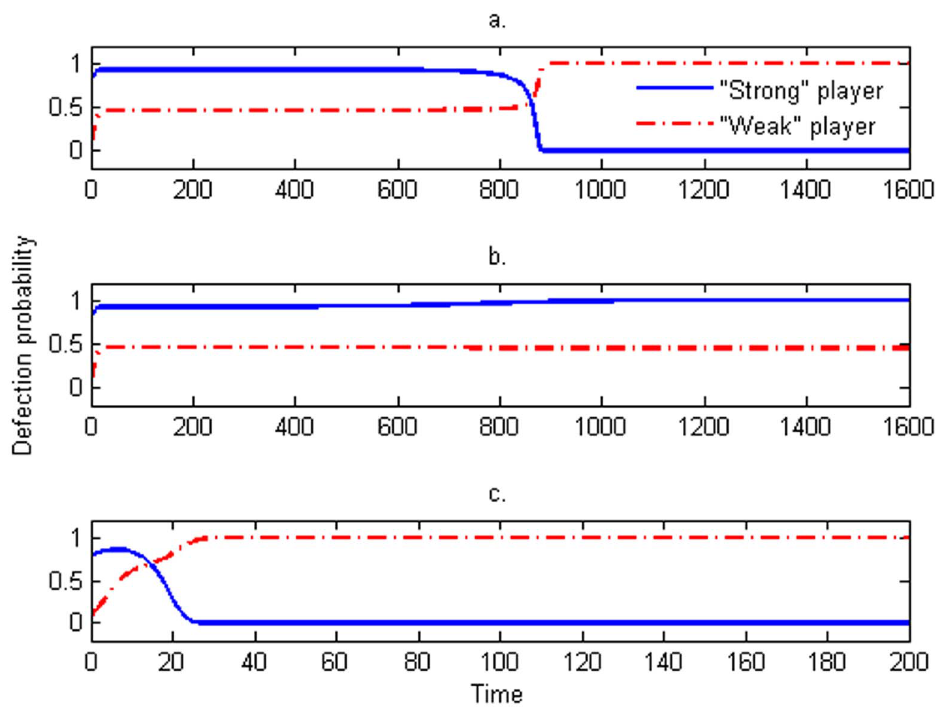
Figure 3. The numerical solution of the replicator dynamics for different initial values. The initial values ( b S (0), b W (0)) are (0 : 7947,0 : 1) , (0 : 7948,0 : 1) and (0 : 7948,0 : 1) in (a), (b) and (c) respectively, where b S (0) and b W (0) are the initial values of the defection probability of the ‘‘strong’’ player and the ‘‘weak’’ co-players respectively. The cost K W ~ 0 : 2 in (a) and (b) while K W ~ 0 : 4 in (c). The other parameters are fixed at K S ~ 0 : 1, U S ~ 1, U W ~ 1 and N ~ 4 .